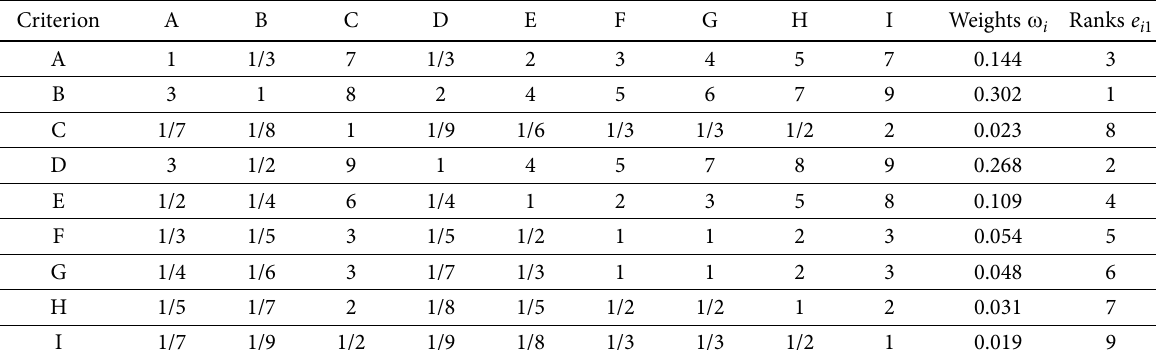
Table 2. Data on comparing the criteria elicited from expert 1